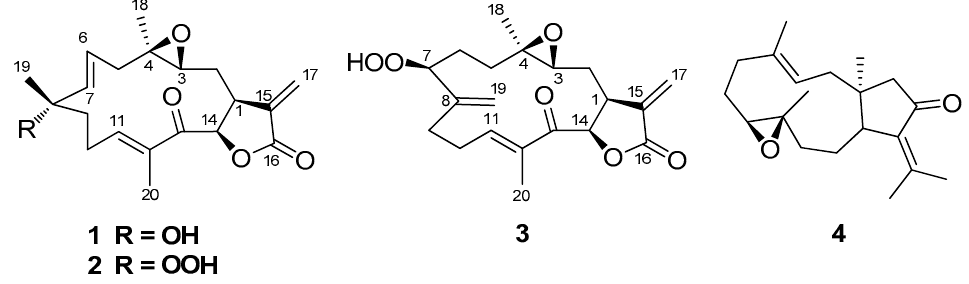
Figure 1. Structures of compounds 1 – 4 .